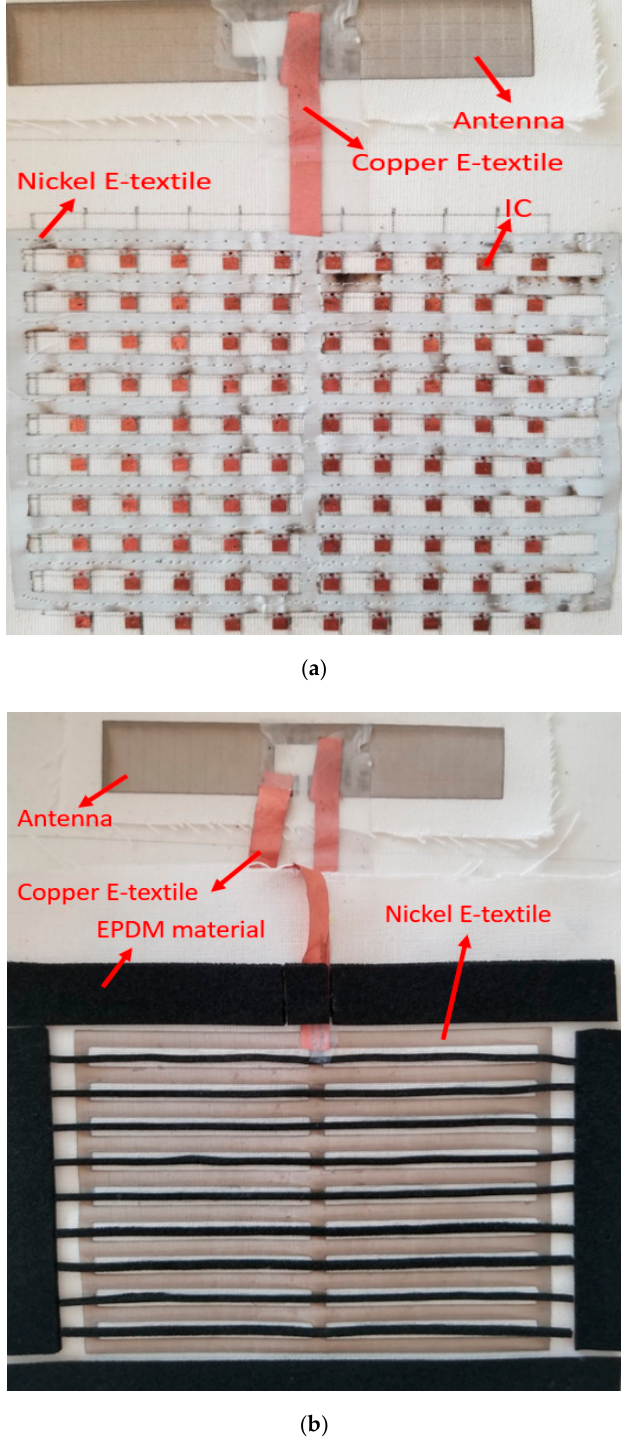
Figure 1. Fabricated platform. ( a ) bottom; ( b ) top layer with separation material.